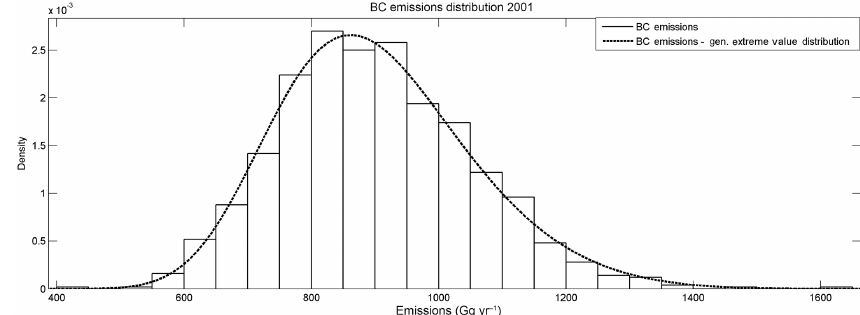
Figure 9. Gen. extreme value distribution fit for the national BC